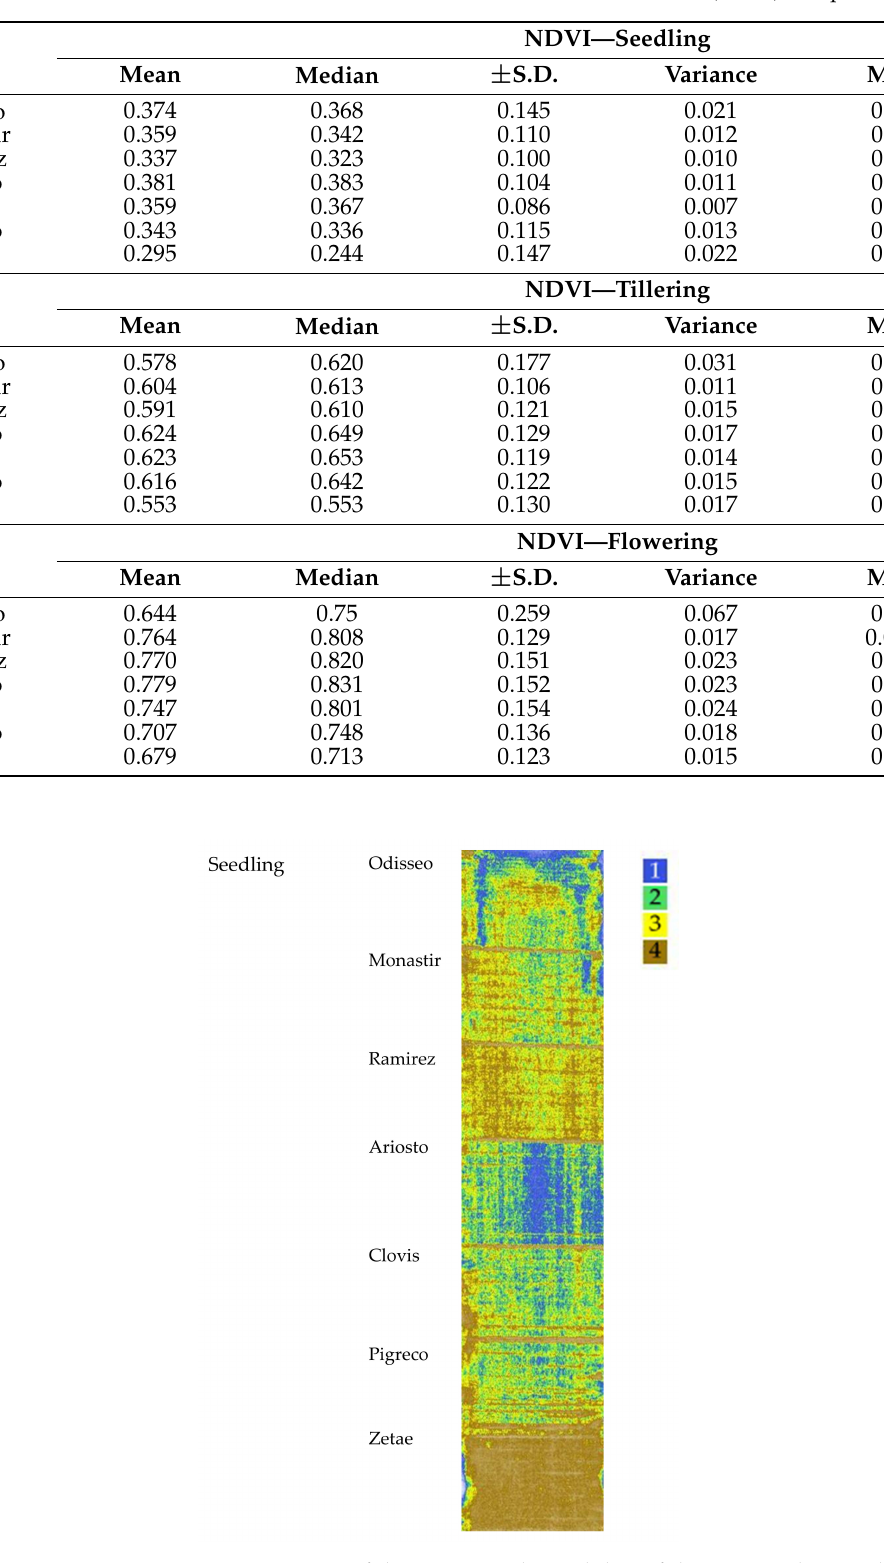
Table 2. NDVI pixel frequency distribution of the durum wheat cultivars at seedling, tillering, and flowering (mean, median, standard deviation, variance, minimum, maximum, median absolute deviation (MAD) and pixel count).